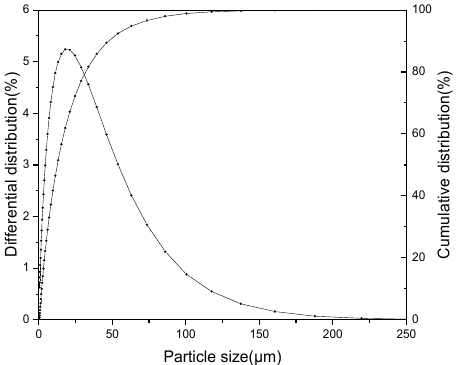
Figure 1. Particle size distribution curves of − 0.5 mm coal sample.